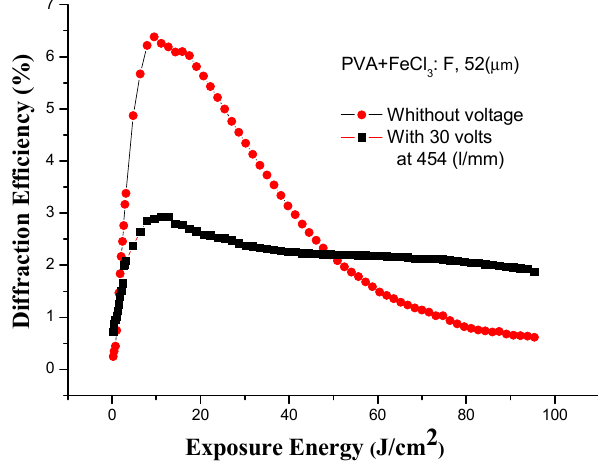
Figure 12. First-order diffraction intensity vs. exposure time with and without an applied voltage of 30 V for grating with 454 lines/mm, made from sample